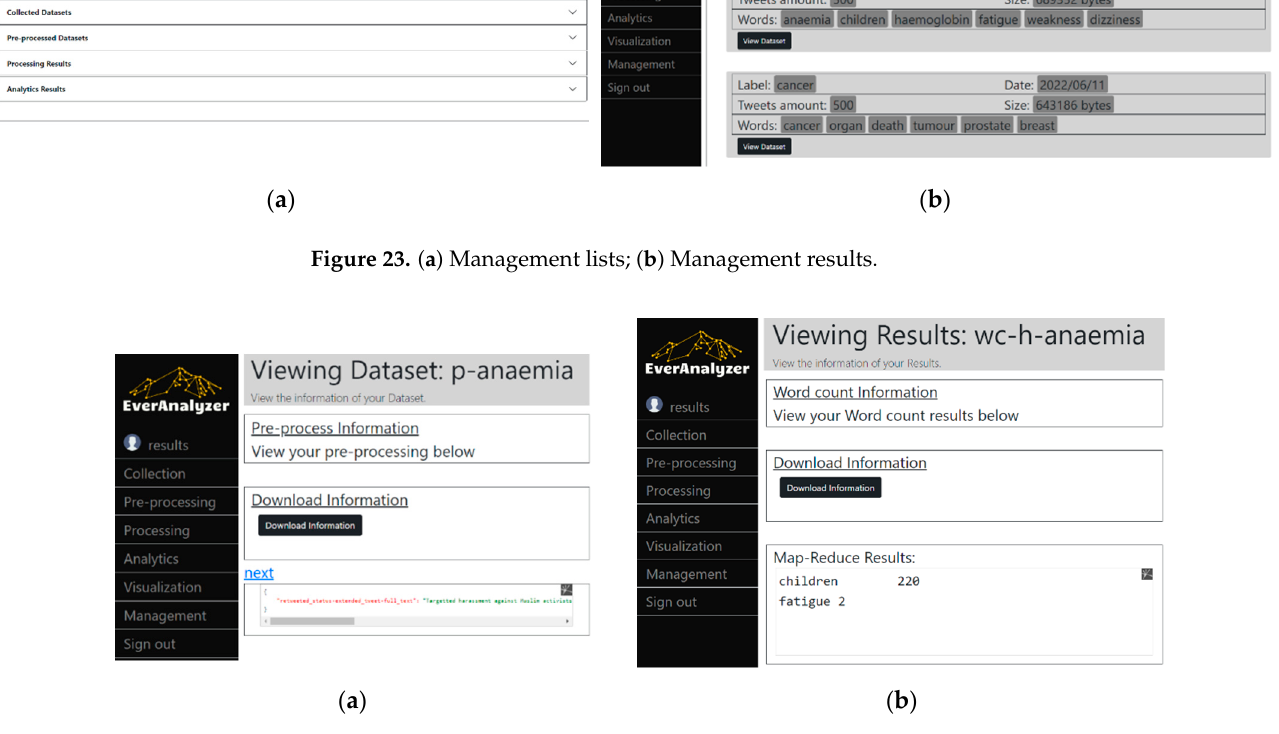
Figure 24. ( a ) Viewing pre-processing results; ( b ) Viewing processing results.